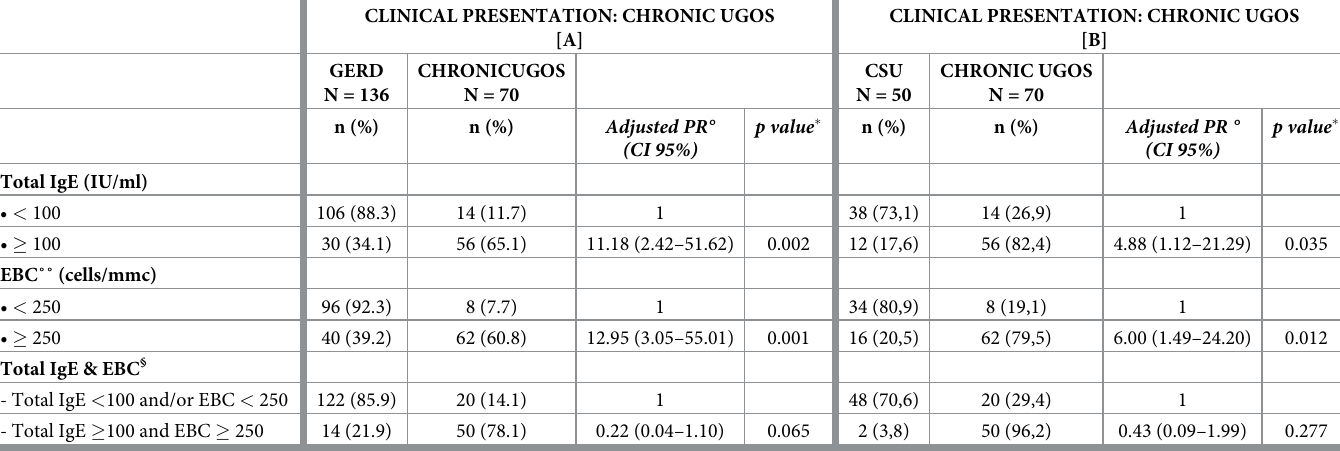
Table 6. Association between chronic urticaria and GERD overlap syndrome (Chronic UGOS) with serum total IgE and eosinophils blood count in patients suffer- ing from gastroesophageal reflux disease (GERD) [A] or chronic urticaria [B].